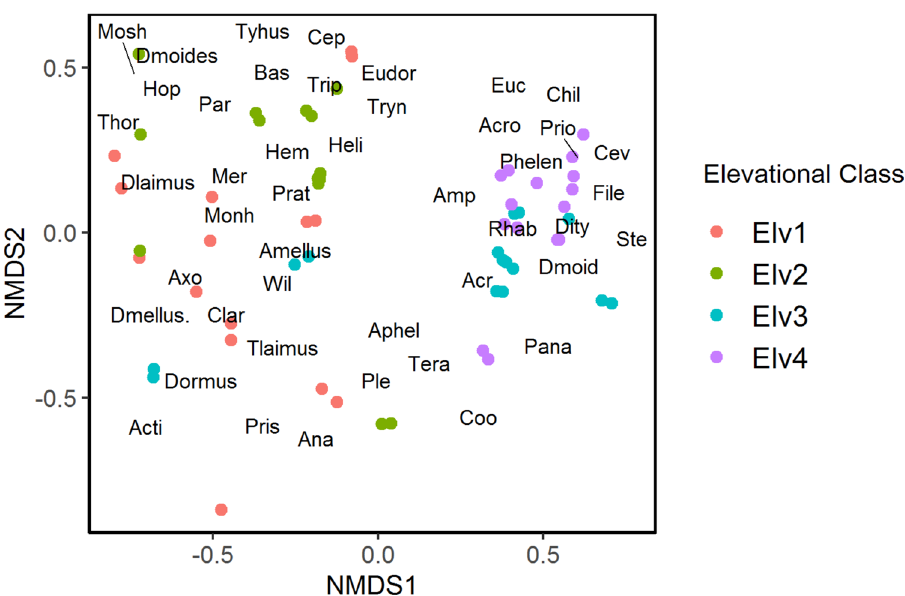
Figure 2. Bray–Curtis dissimilarity (NMDS ordination) of nematode communities based on abundances of nematode genera. Each point displays the community found in an individual sample (n = 15 samples per elevation class × 4 classes = 60). Points that are close proximity have more similar communities than points that are distant from each other. Colors show Elevation class (Where Elv1: 3000–3500 m; Elv2: 3501–4000 m;